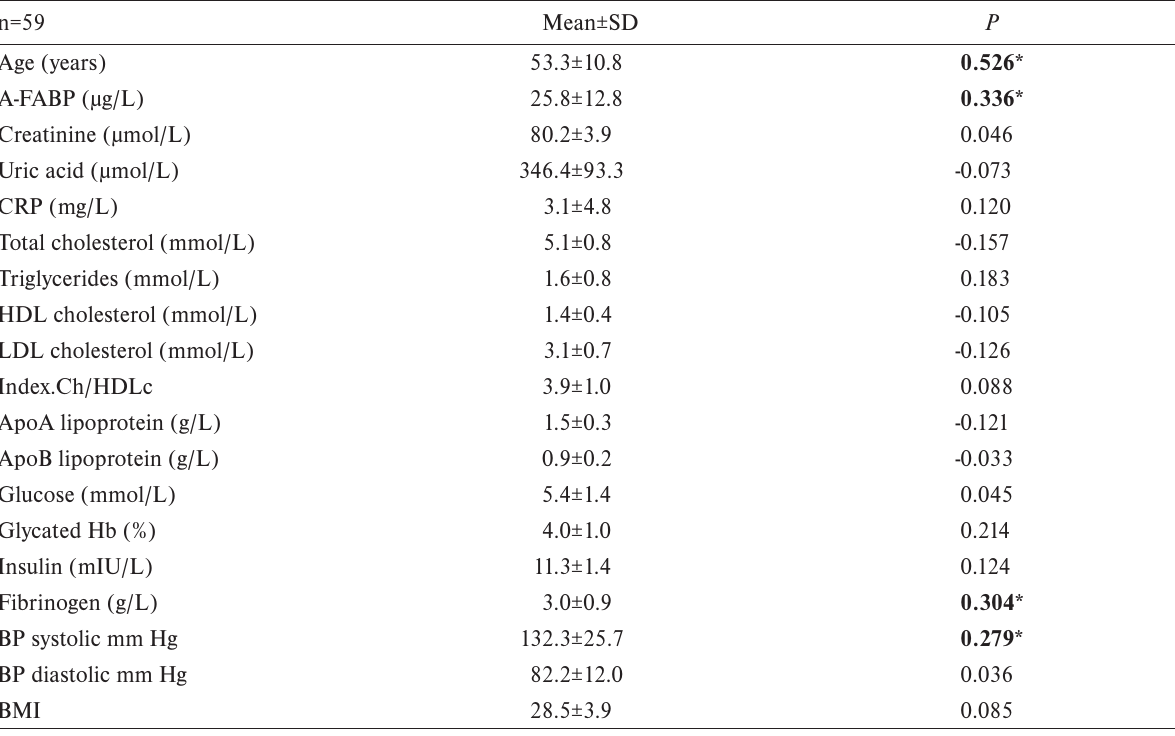
Table 1. Basic characteristics and correlation coefficients with epicardial fat.